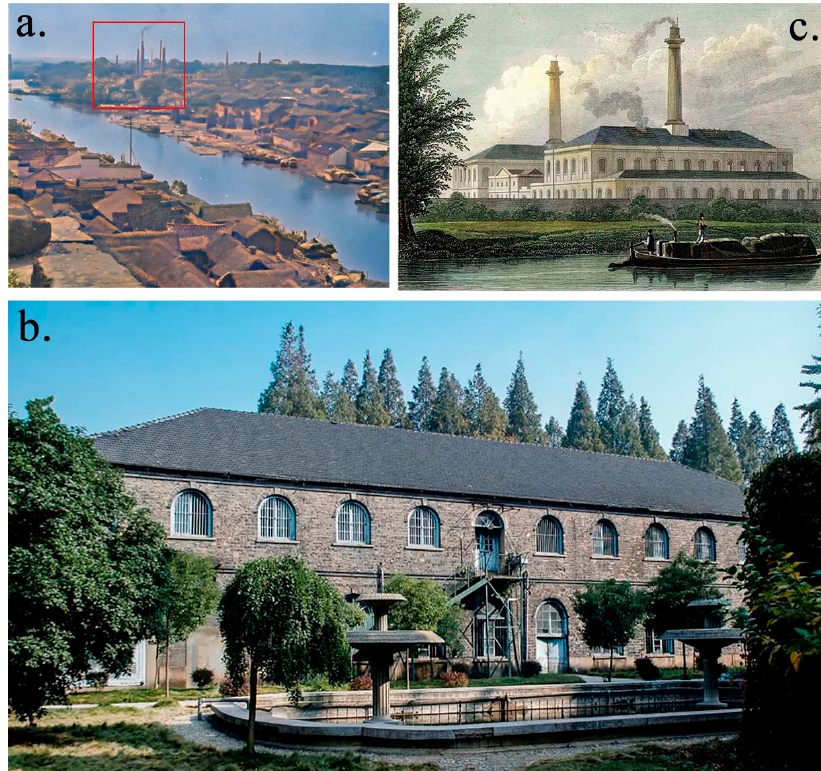
Figure 7. The Jinling Machinery Bureau in the early 20th century ( a ); the appearance of the LMF before restoration ( b ); the Imperial Gas Light Co. on Regent’s Canal in London in the early 19th century ( c ). ( a , c ) from [40]; picture in ( b ) taken by Y.W.